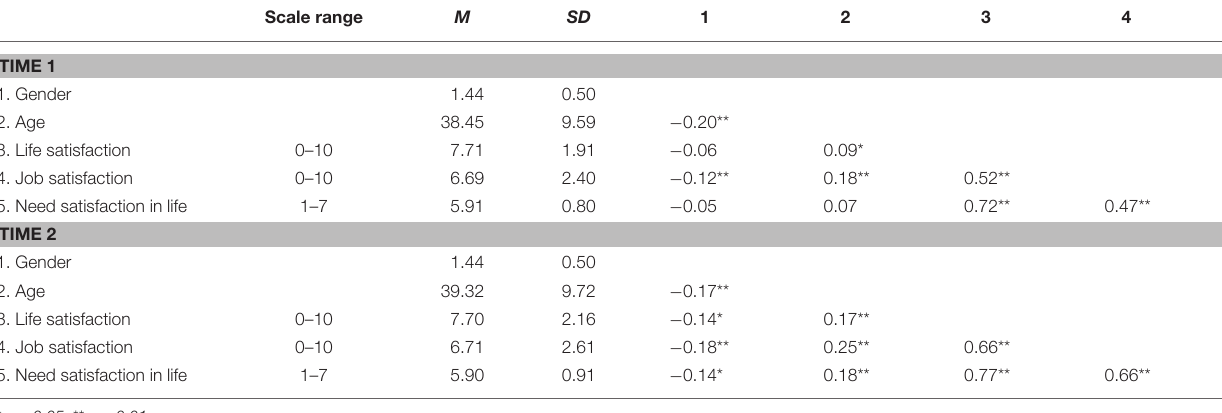
TABLE 5 | Descriptives and inter-correlations between all study 3 variables. Scale range